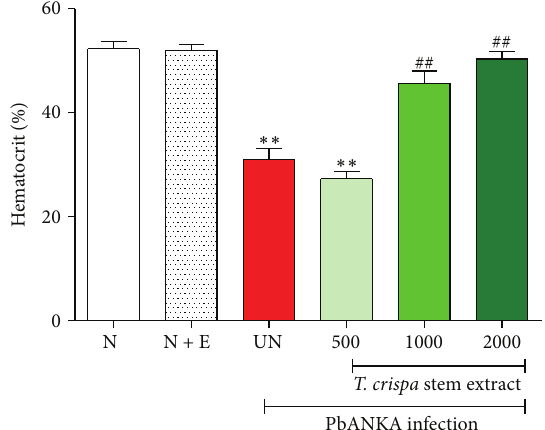
Figure 3: Protective effect of Tinospora crispa stem extract on hemolysis induced by Plasmodium berghei infection. ICR mice (5 miceofeach)wereinoculatedwith1 × 10 7 parasitizederythrocytesof PbANKA by intraperitoneal injection. The extracts (500, 1000, and 2000 mg/kg) were given orally by gavage for 4 consecutive days. On day 4 of experiment, hematocrit levels were then measured. Results were expressed as mean ± SEM. ∗∗ 𝑃 < 0.01, compared to normal control, and ## 𝑃 < 0.001, compared to untreated control. N: normal control, N + E: normal mice treated with 2000 mg/kg of extract, and UN: untreated control. The results came from 3 independent